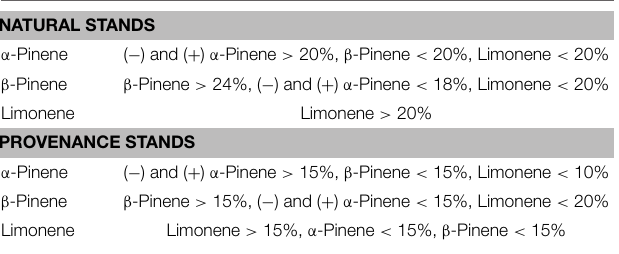
TABLE 1 | Approximate defining properties of the three chemotypes derived from a hierarchical cluster analysis of jack pine ( Pinus banksiana ) trees in (a) natural stands in populations of eastern Canada and northeastern U.S.A., and (b) provenance stands representing jack pine populations from Alberta to the Atlantic coast.